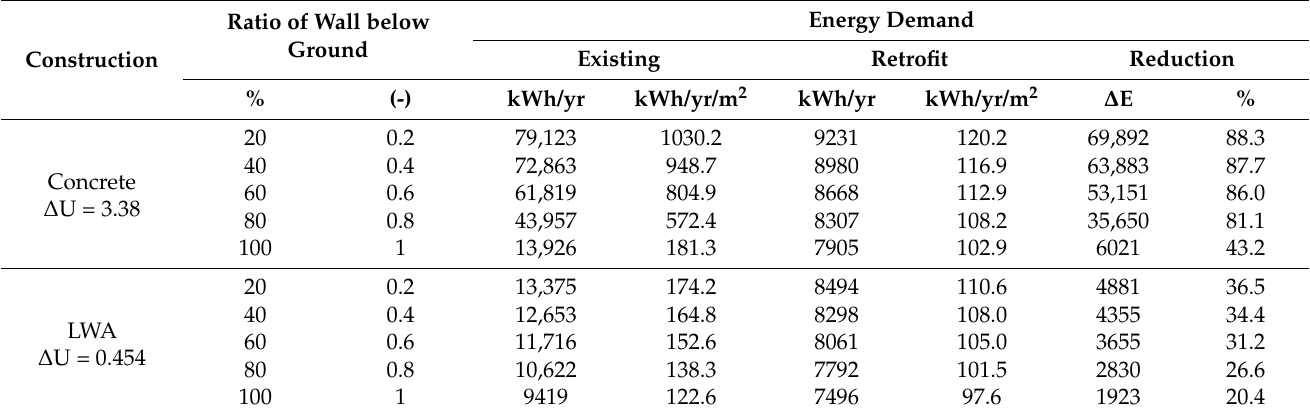
Table 5. Energy consumption before and after upgrading.